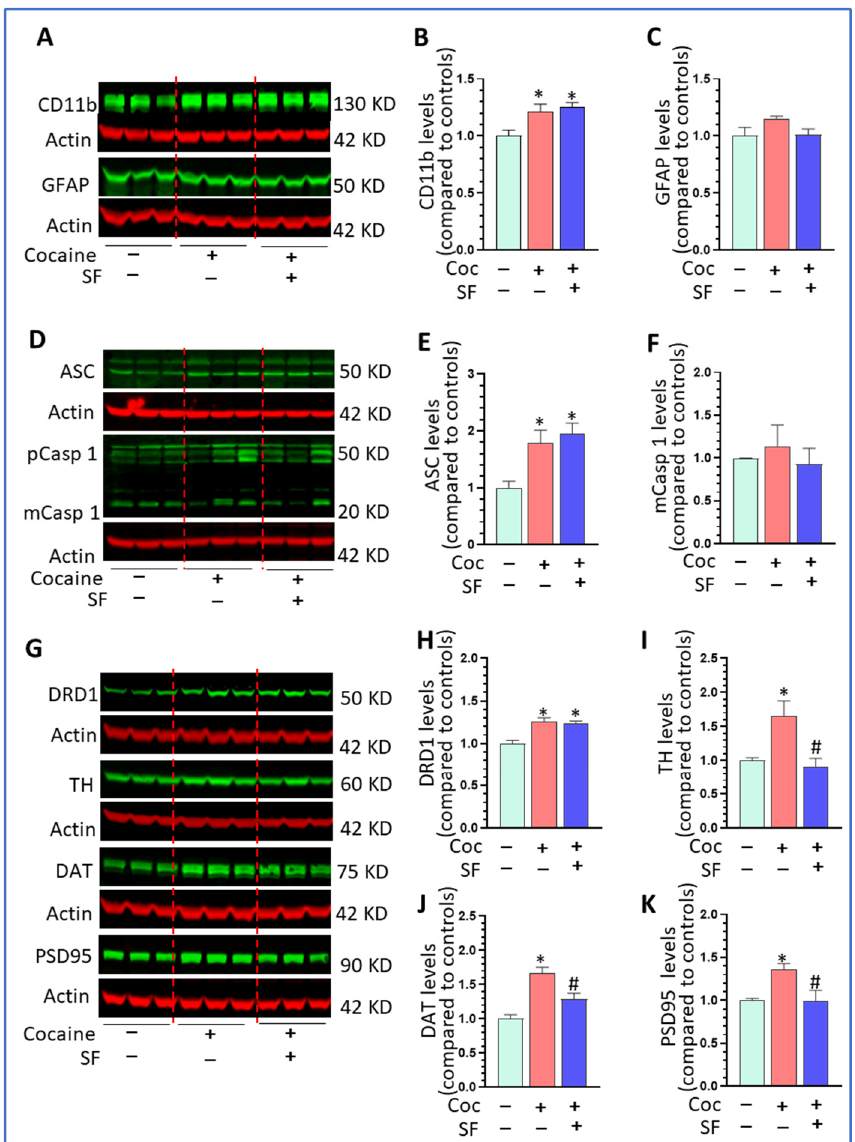
Figure 7. Effects of SF and cocaine on microglial activation and dopamine system in the withdrawn mice. ( A ) Representative WBs images for CD11b and GFAP in the striatum of three groups of mice; β -actin served as a protein load control. ( B ) Challenging with cocaine significantly increased CD11b levels in chronic ±SF mice (* p < 0.05, vs. sham + saline). ( C ) Challenging with cocaine had no effects on GFAP levels across groups ( p > 0.05). ( D ) Representative WBs images for ASC and Casp 1 in the striatum of three groups of mice; β -actin served as a protein load control. ( E ) Challenging with cocaine significantly increased ASC levels in chronic ±SF mice (* p < 0.05, vs. sham + saline). ( F ) Challenging with cocaine had no effects on mCasp 1 levels across groups ( p > 0.05). ( G ) Representative WBs images for DRD1, TH, DAT, and PSDs95 in the striatum of three groups of mice; β -actin served as a protein load control. ( H ) Challenging with cocaine significantly increased DRD1 levels in chronic ±SF mice (* p < 0.05, vs. sham + saline). ( I ) Challenging with cocaine significantly increased TH levels and SF blocked such upregulation (* p < 0.05, vs. sham + saline, # p < 0.05, vs. sham + cocaine). ( J ) Challenging with cocaine significantly increased DAT levels and SF blocked such upregulation (* p < 0.05, vs. sham + saline, # p < 0.05, vs. sham + cocaine). ( K ) Challenging with cocaine significantly increased PSDs95 levels and SF blocked such upregulation (* p < 0.05, vs. sham + saline, # p < 0.05, vs. sham + cocaine).